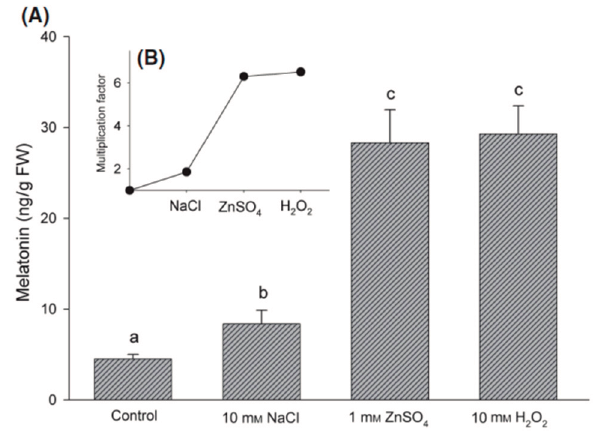
Figure 3. ( A ) Increase in melatonin levels in barley roots after exposure to various treatments for 72 h; ( B ) Fold increases relative to control value. FW = fresh weight. Different letters indicate statistically significant differences ( p < 0.05). From Arnao and Hernandez-Ruiz [105] with